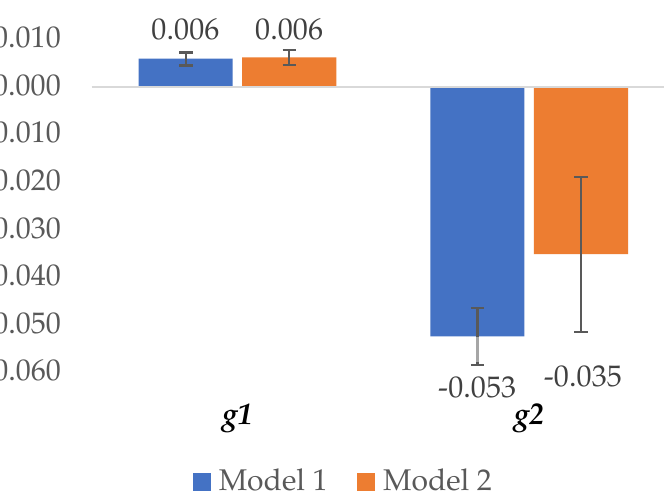
Figure 1. Impact of RE on productive inefficiency: the whole sample ( g 1 ) vs. high-income countries ( g 2 ). Furthermore, we find that including TPES increases returns to scale (Model 1: RTS is about 0.89; in Model 2, it is 0.96) and decreases elasticities of capital and labor. As Figure 2 clearly indicates, when TPES is present in the model, it is the most influential factor of GDP growth, i.e., 1 pp growth in TPES results in 0.41 pp growth in GDP, ceteris paribus. Moreover, if TPES is excluded from the model, as in Model 1, the elasticities of capital and labor are significantly negatively correlated ( − 0.662), which is to be expected, as their contribution to production is somewhat substitutional. However, when TPES is included (Model 2), capital and labor elasticities are almost uncorrelated ( − 0.087), and the elasticity of TPES is significantly negatively correlated with the other two factors ( − 0.567 and − 0.546, respectively). This leads to the following conclusion in terms of hypothesis H3 mentioned in Sections 1 and 2: the energy supply is an important factor influencing economic growth because (i) it changes the contribution of the main input factors (capital and labor), which is substantially diminished by TPES (which now has the highest average elasticity), and (ii) it changes the interaction between capital and labor elasticities; their correlation in Model 2 is negligible, while they both correlate with TPES